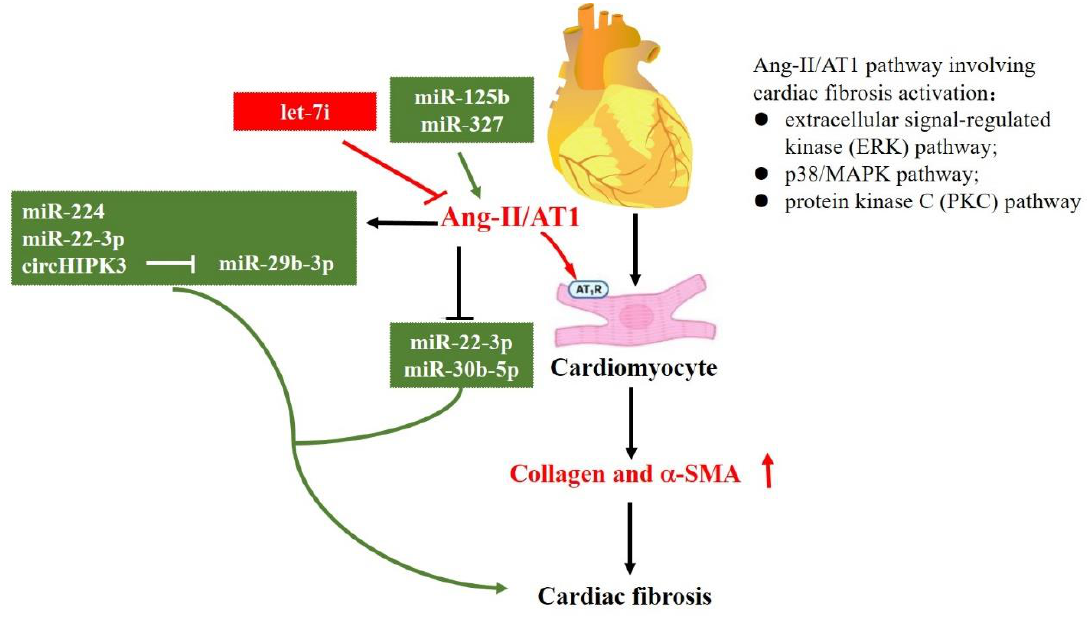
Figure 4. MiRNAs in the regulation of Renin-Angiotensin-Aldosterone System (RAAS). This figure shows miRNAs that regulate the expression of RAAS pathways. The symbol of “——>” means positive effect, and the symbol of “——|” means negative effect.